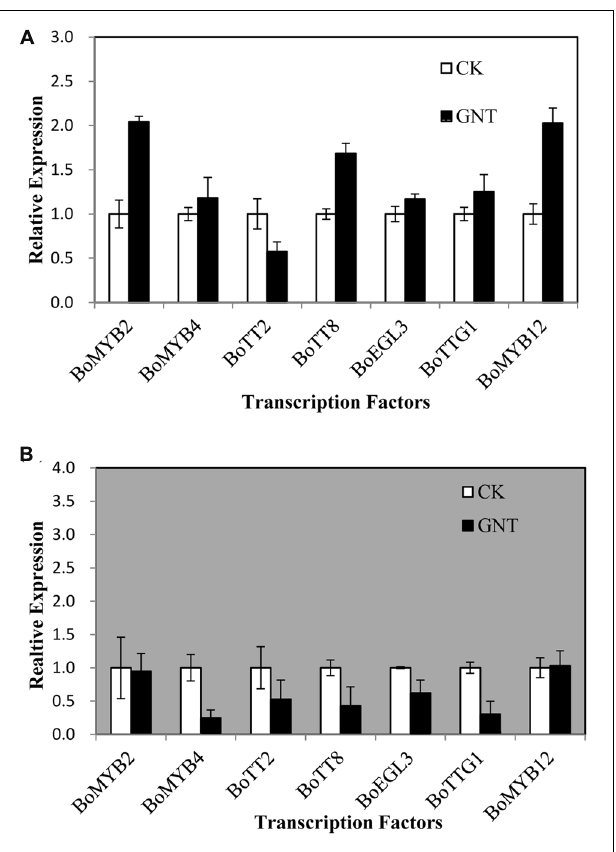
FIGURE 6 | Expression levels of transcription factors regulating anthocyanin biosynthesis under genistein treatments. (A) is under light conditions and (B) is under dark conditions. The data are mean ± SD ( n = 3), Vertical bars represent ± SD